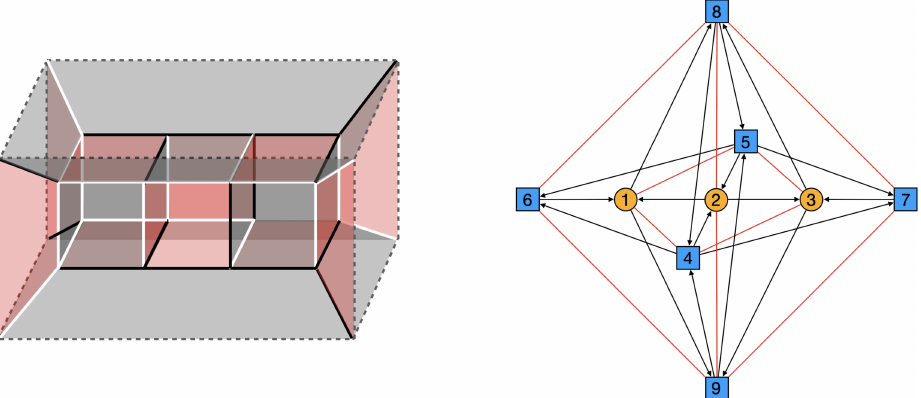
Figure 30 . The 3-cube model and its dual